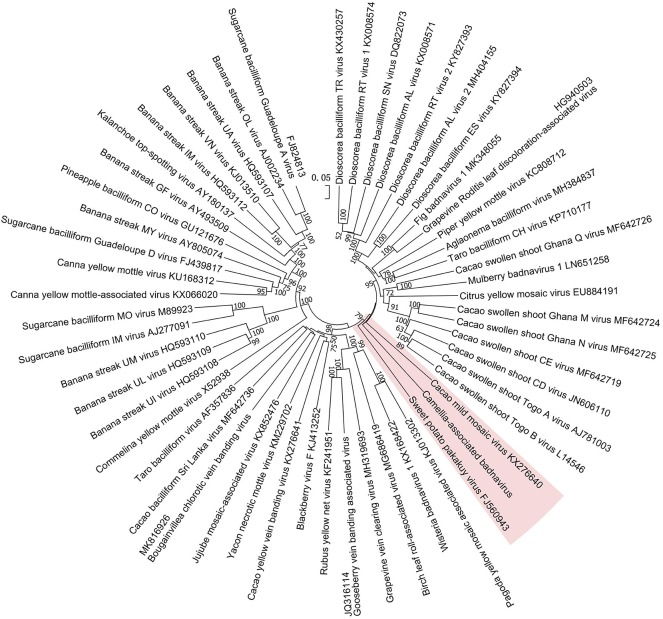
Phylogenetic analysis of full-genome sequences of Camellia-associated badnavirus (CaBaV) and representative badnaviruses. The CaBaV and its most associated viruses are indicated by the red background. Bootstrap values (1,000 replications) are shown only if they were above 50%.